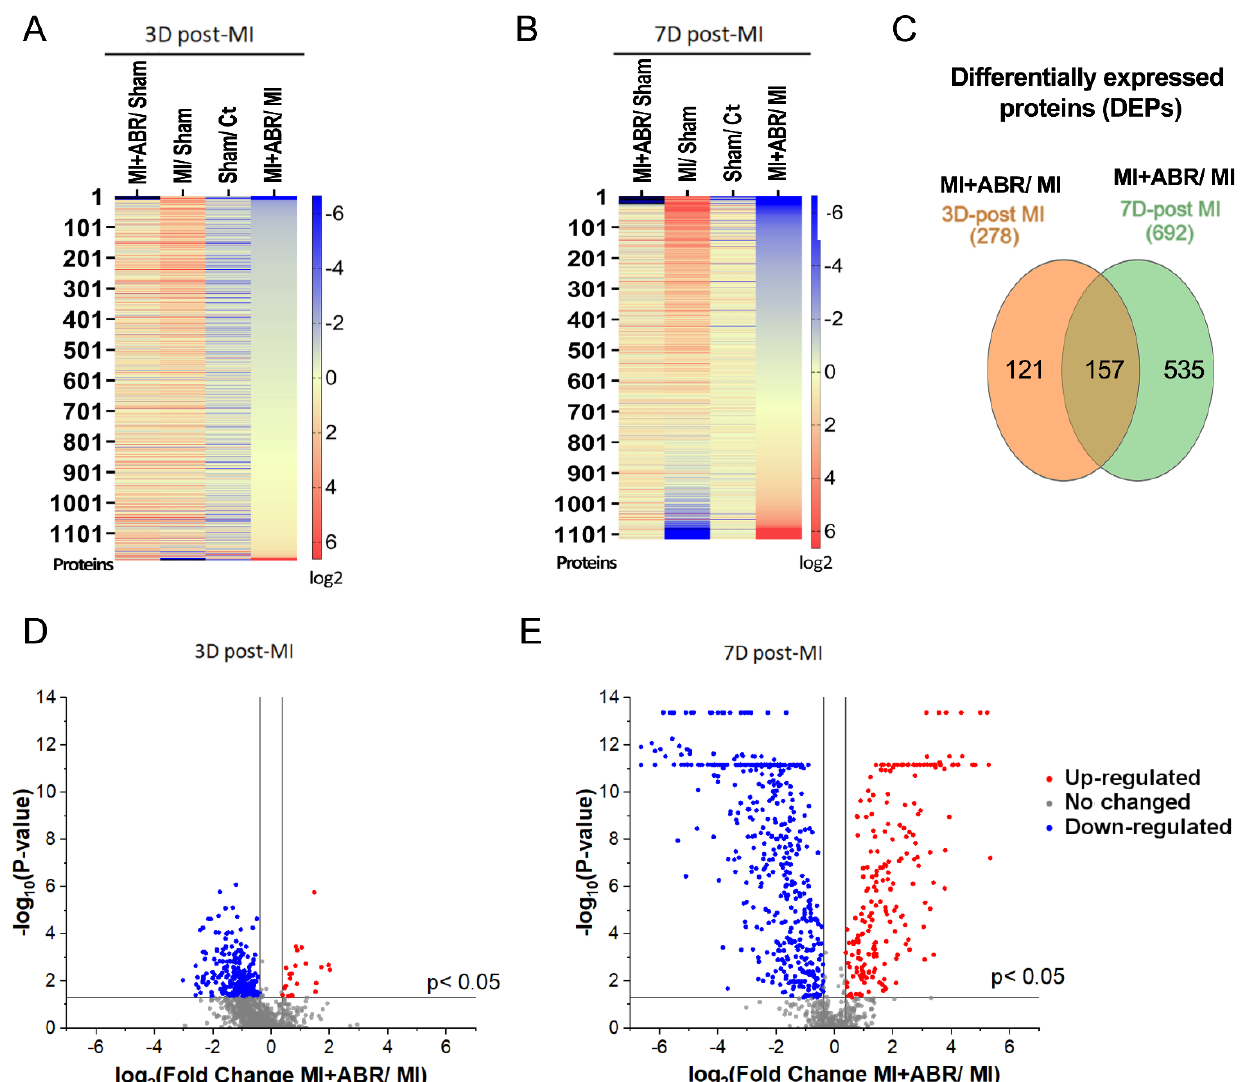
Figure 1. Proteomic analysis of left ventricle on day 3 and 7 post-MI. The left ventricle was separated from the heart, harvested and processed for future analysis. ( A ) At 3 days (3D) post-MI, 1192 proteins were identified in the unoperated control (Ct), Sham, MI, and MI + ABR groups. The relative protein expression is presented as a pairwise comparison between the groups, where deeper blue represents lower abundance and deeper red represents higher abundance. ( B ) At day 7 post-MI (7D), a total of 1117 proteins were identified. ( C ) Venn diagram showing the number of common and different up- or downregulated proteins in MI + ABR versus MI control hearts at 3 and 7 days post-MI ( D , E ). Volcano plots of differential protein abundance, with fold difference between the log2 normalized abundance in the MI + ABR and MI groups plotted versus − log10 adjusted p value, at 3 D post-MI and 7 D post-MI. Each dot represents a protein. Colored dots represent the expression profiles of significantly different proteins with a relative fold change of ≥ 1.30 or ≤ 0.77. The calculated p value was obtained using ANOVA hypothesis test and was adjusted using Benjamini-Hochberg correction for the false discovery rate.